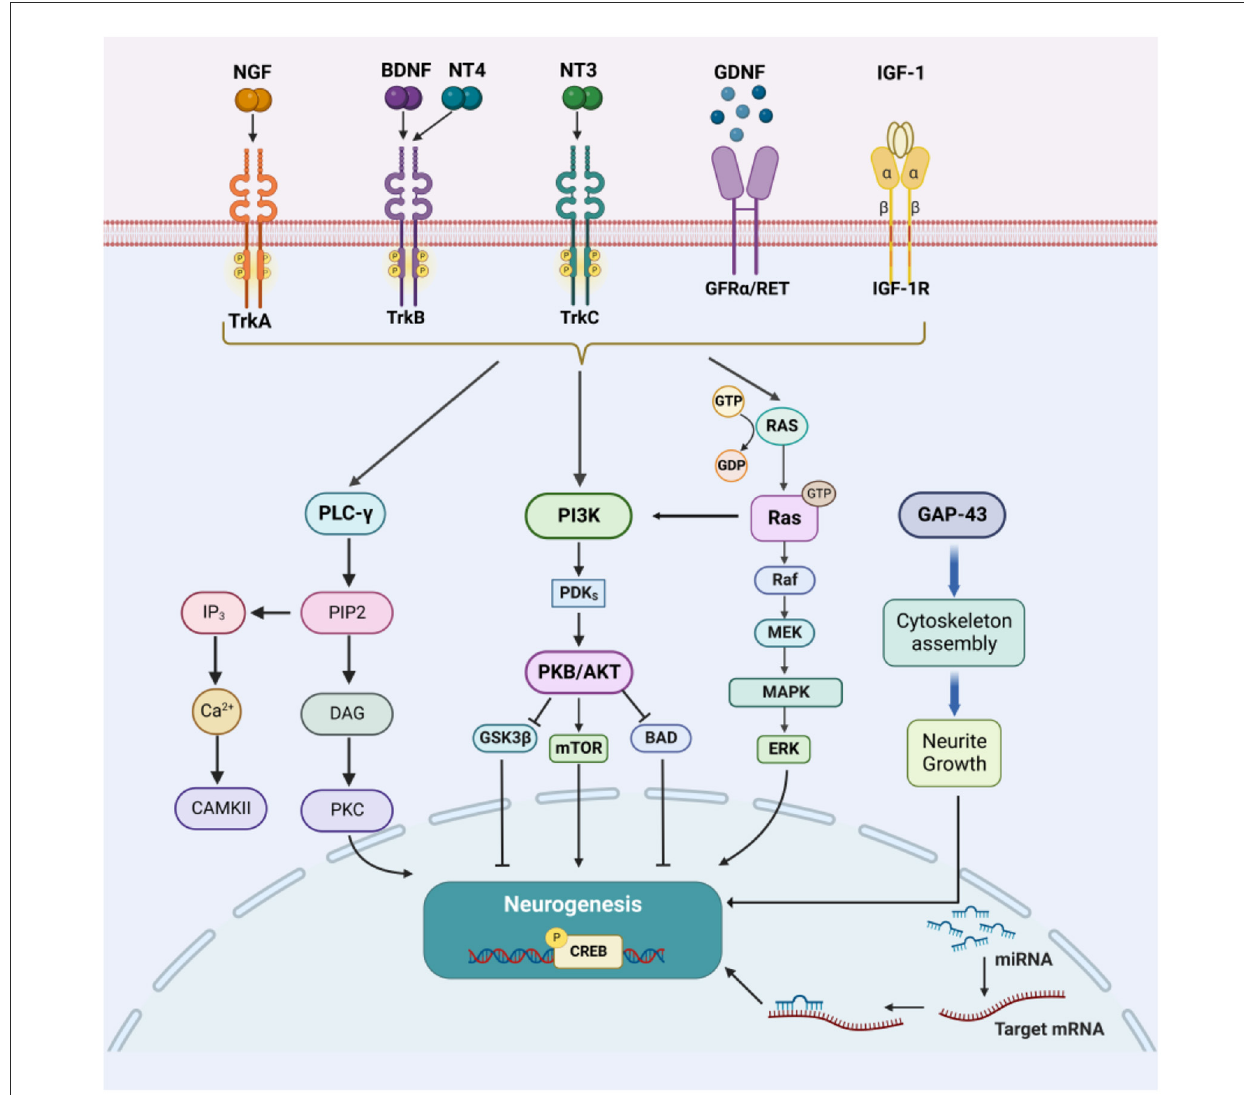
FIGURE1 Diagram showing the factors that enhance neurogenesis and their major downstream signaling pathways following brain injury and stroke. Reprinted from Mu et